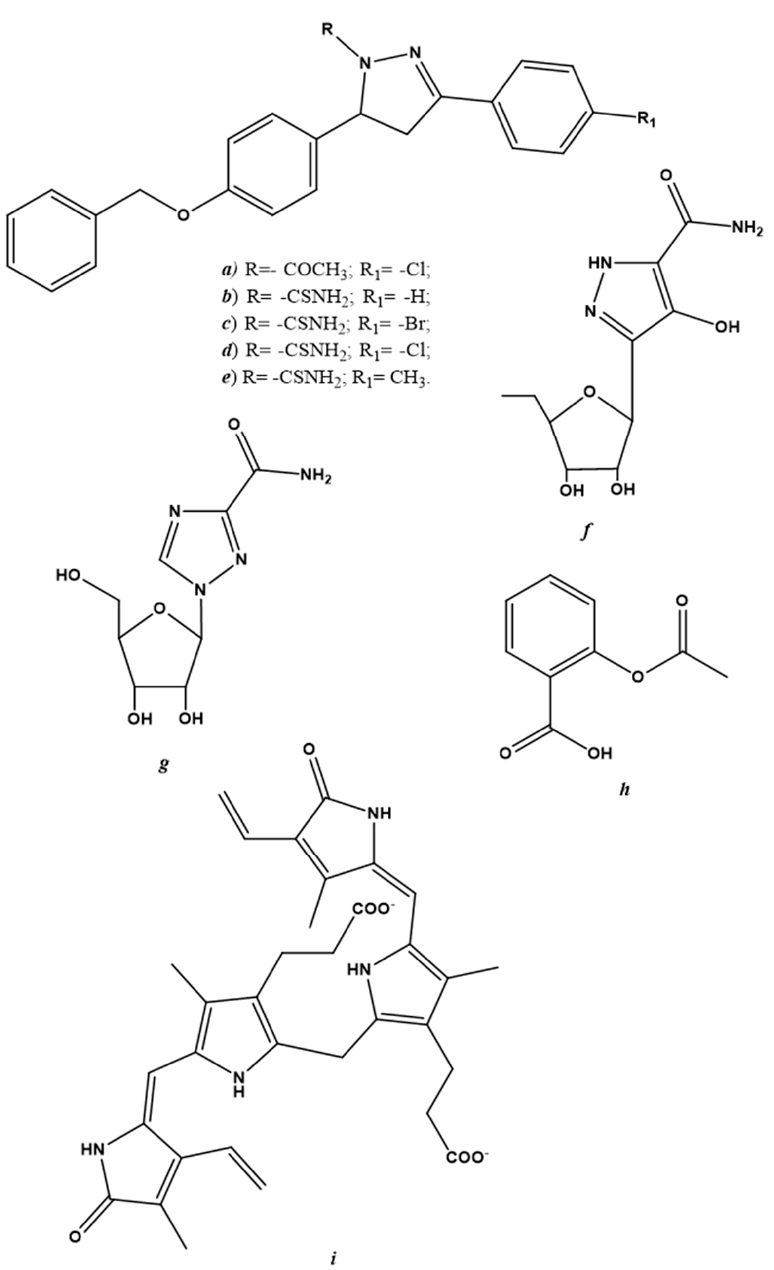
Figure 3. Chemical structure of endogenous NO-regulating drugs. ( a – f ) pyrazole derivatives; ( g ) ribavirin; ( h ) acetylsalicylic acid; ( i ) bilirubin. ( g ) ribavirin; ( h ) acetylsalicylic acid; ( i ) bilirubin.